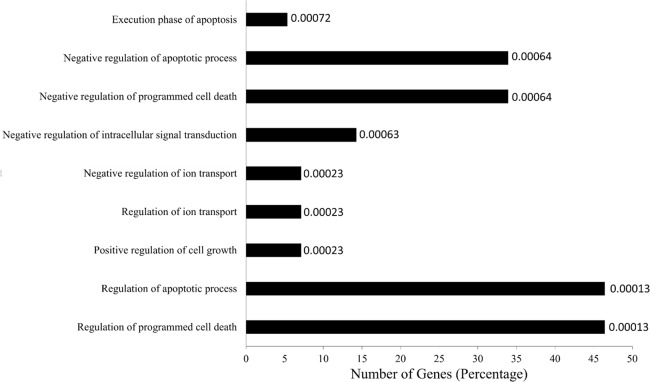
miRNA target genes were analyzed for GO enrichment and mapped for GO category.Percentage of target genes involved in each GO term. The represented GO terms were significant at p-value > 0.0001. The values at the end of the bars represent the p-values.